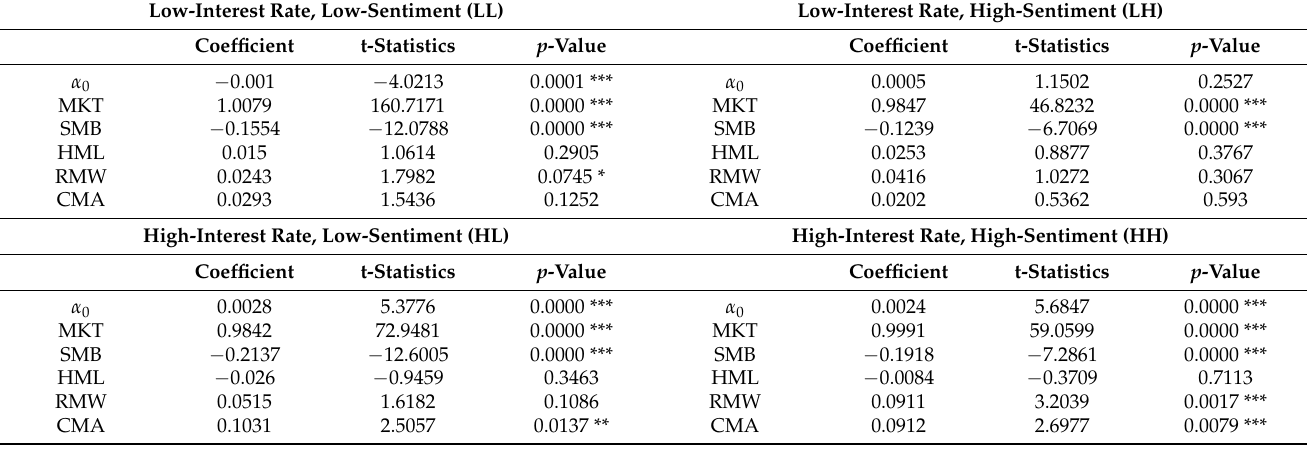
Table 9. Five-factor adjusted stock returns in market cycles (nominal interest rate and consumer sentiment). The table reports the five-factor adjusted returns of the S&P 500 in the four market cycles. The median of the long-term nominal interest rate is 5.81%, greater than (less than) the median defined as a high-interest rate (low-interest rate) cycle. The median of consumer sentiment is 89.6, greater than (less than) the median defined as a high-sentiment (low-sentiment) cycle. If the dummy variable Dr equals 1, it indicates a high-interest rate cycle, and 0 otherwise; if the dummy variable Ds equals 1, it indicates a high-sentiment cycle, and 0 otherwise. Adjusted R-square: 0.9962 (LL); 0.9825 (LH); 0.9899 (HL); 0.9921 (HH). All t-statistics are based on the Heteroskedasticity-Autocorrelation-Consistent standard errors. *, **, and *** denote significance at the 10%, 5%, and 1% levels, respectively.